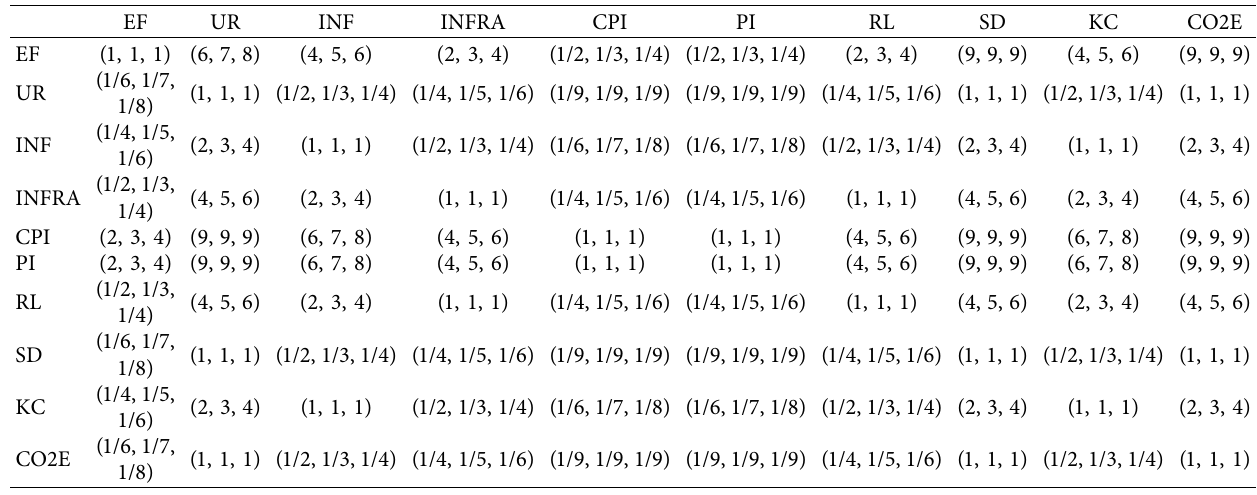
Table 10: Fuzzy pairwise comparison matrix.